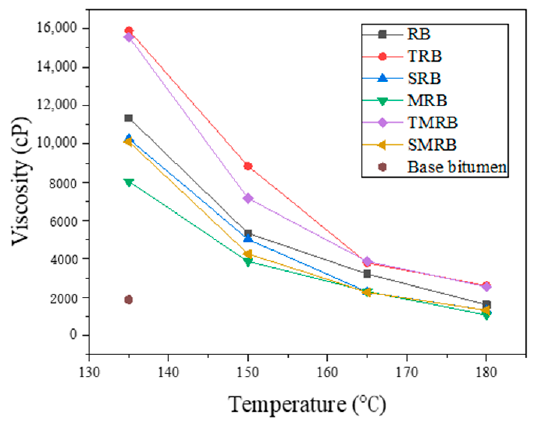
Figure 9. Viscosity of rubberized bitumen at different temperatures.